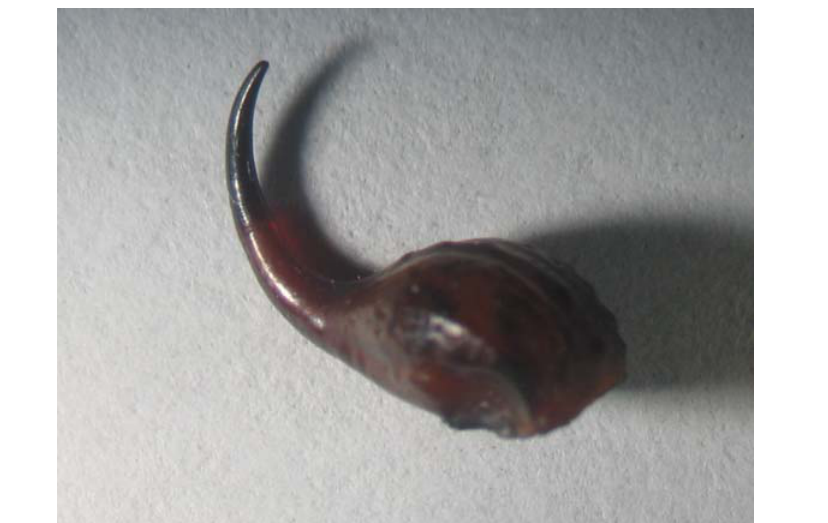
Figure 2. Telson removed from a dead Androctonus crassicauda at the point of its articulation with the last caudal segment.